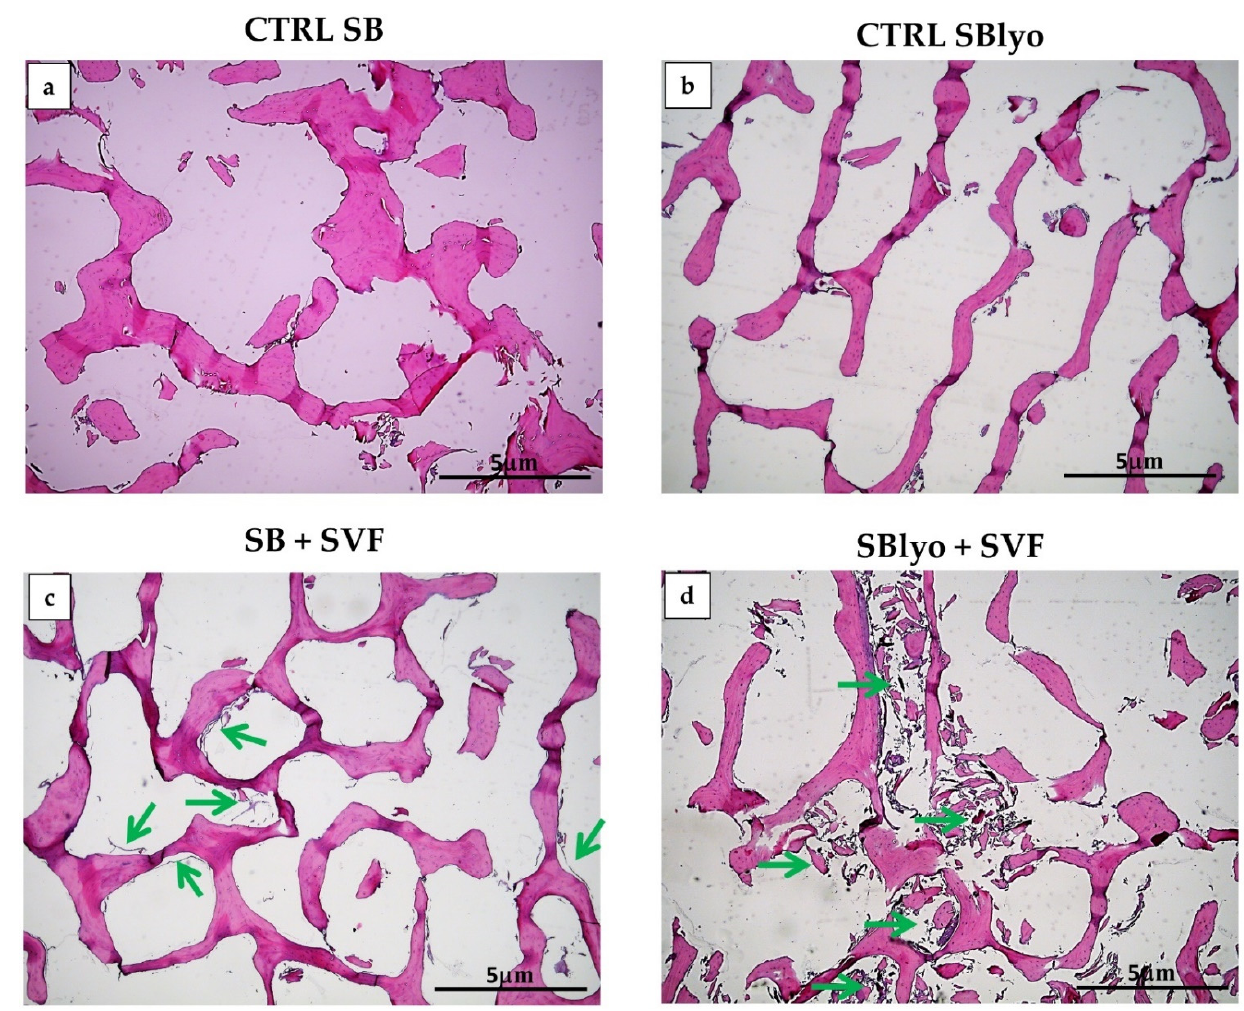
Figure 4. Growth of cells on SB and SBlyo after 14 days. H&E staining shows empty trabeculae of SB ( a ) and SBlyo ( b ) without cell seeding (CRTL), whereas the initial growth of SVF cells on SB ( c ) and SBlyo ( d ) was evident (green arrows). Magnification 4×. Scale bar: 5 µm.